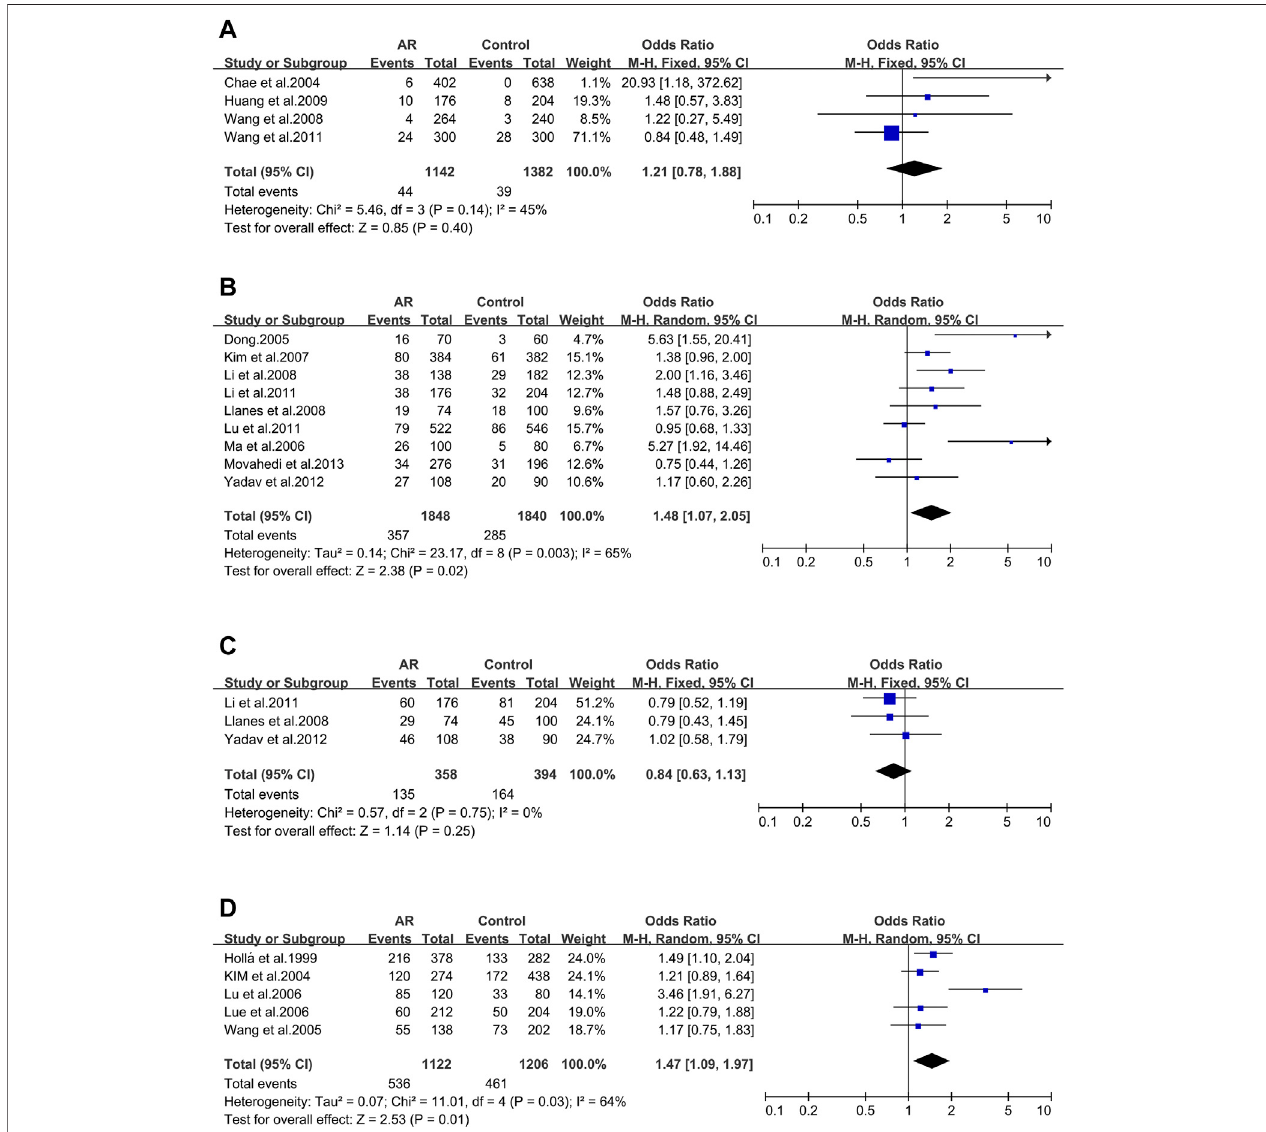
FIGURE6| ForestplotsforTim-3,IL-4RandACEpolymorphisms. (A) Tim-3(rs10515746):Tallele; (B) IL-4R(rs1801275):alleleR; (C) IL-4R(rs1805010):alleleV; (D) ACE (I/D): allele D.